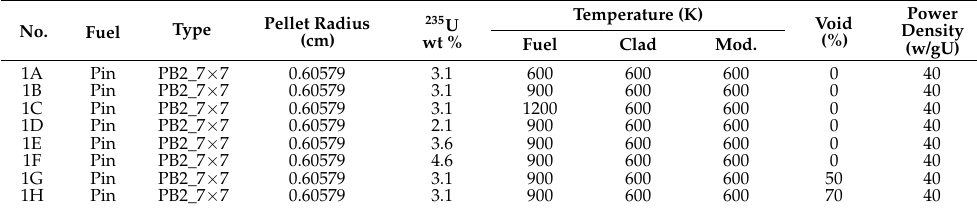
Table 2. Benchmark cases for the BWR VERA depletion